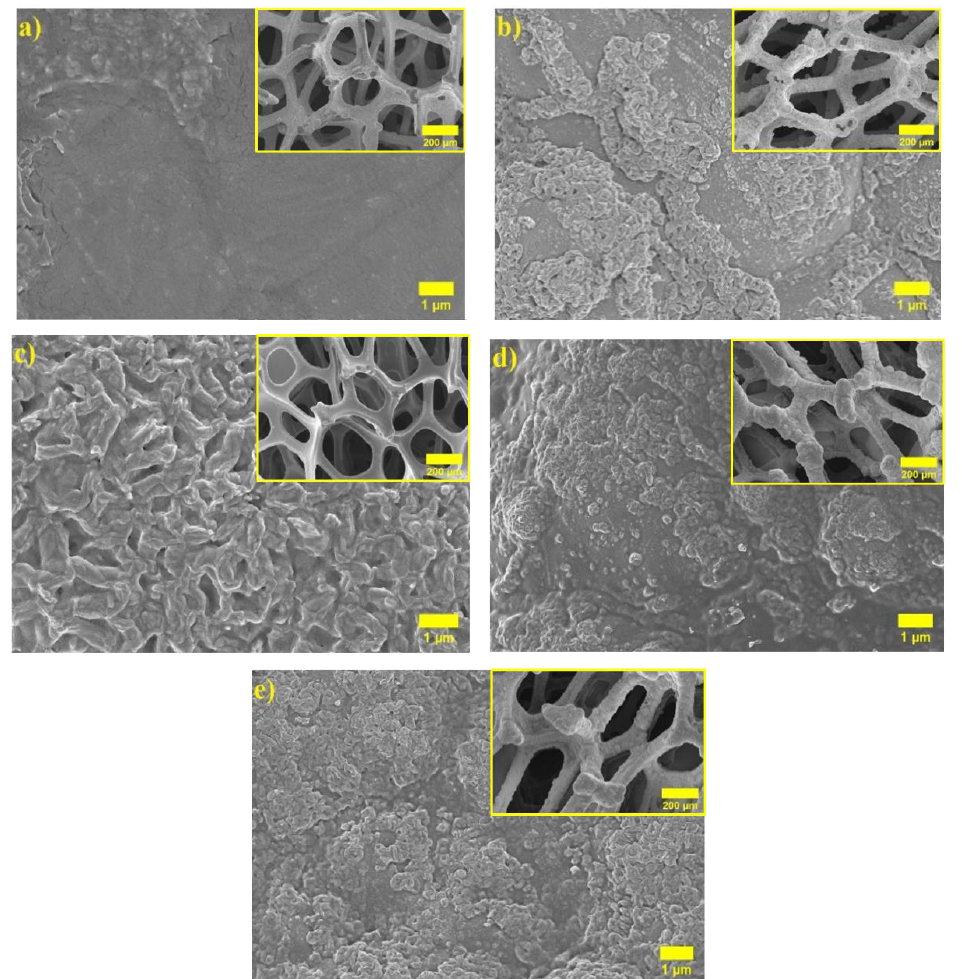
Figure 2a,b present the SEM images of the pristine Ni foam and NiO/Ni foam. A 3D porous structure with uniformly spaced microscale pores is present in the pristine Ni foam (Figure 2a). It can be observed that after thermal oxidation, the surface of the struts of Ni foam became rough (Figure 2b) due to NiO growth. Further, after coating with PAN-(PAN-PVA)-PVA polymer layers, the aggregates of the cauliflower shape were observed, which can be observed in the inset of Figure 2c – e, showing morphology after the addition Al 2 O 3 and the formation of grains on the surface. Since the PAN-(PAN-PVA)-PVA poly- electrolyte coating loaded with 1 M LiPF 6 solution in EC/EMC/DC is intended to act as an electrolyte providing Li + conductance while ensuring electrical insulation of electrodes from each other, the absence of any cracks or holes in the polymer coating is essential for the safe operation of the battery [50].